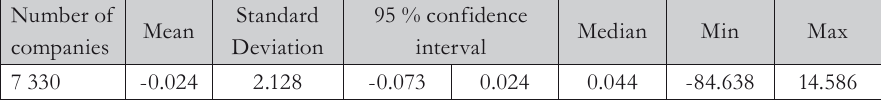
Tab. 3 – Evaluation of the sample – descriptive statistics: ROE. Source: Own investigation.